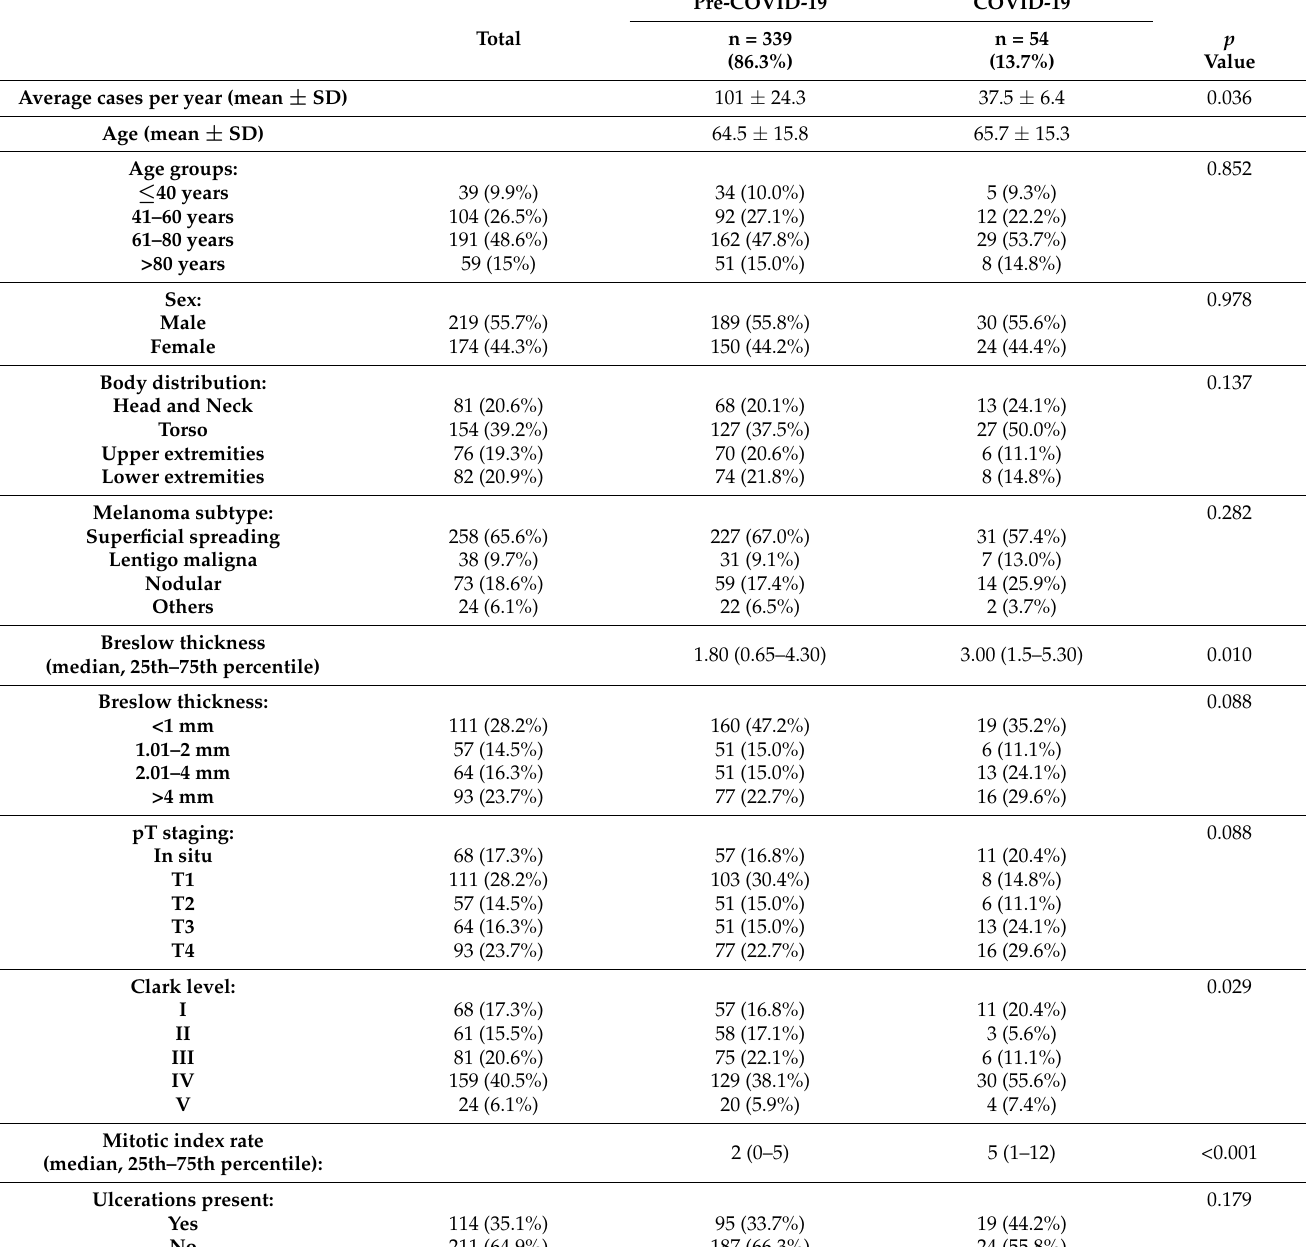
Table 1. General characteristics of melanoma patients before and after the onset of the COVID-19 pandemic. No differences were observed between age, sex, body distribution, histologic subtype, and ulceration status in the two study groups. As shown in the table, patients diagnosed with melanoma after the onset of the pandemic had a higher Breslow thickness median. Higher Clark levels and mitotic index rate during the pandemic were also